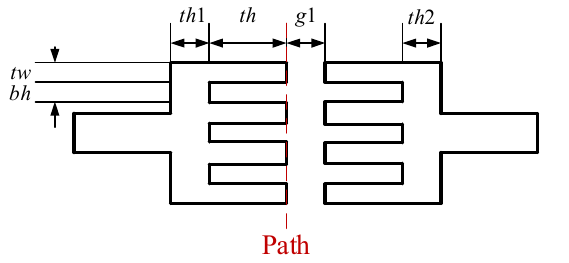
Figure 3. Dimensional parameters for controlling the shape of the microelectrodes. Table 1. Dimensional parameters of the microelectrodes.